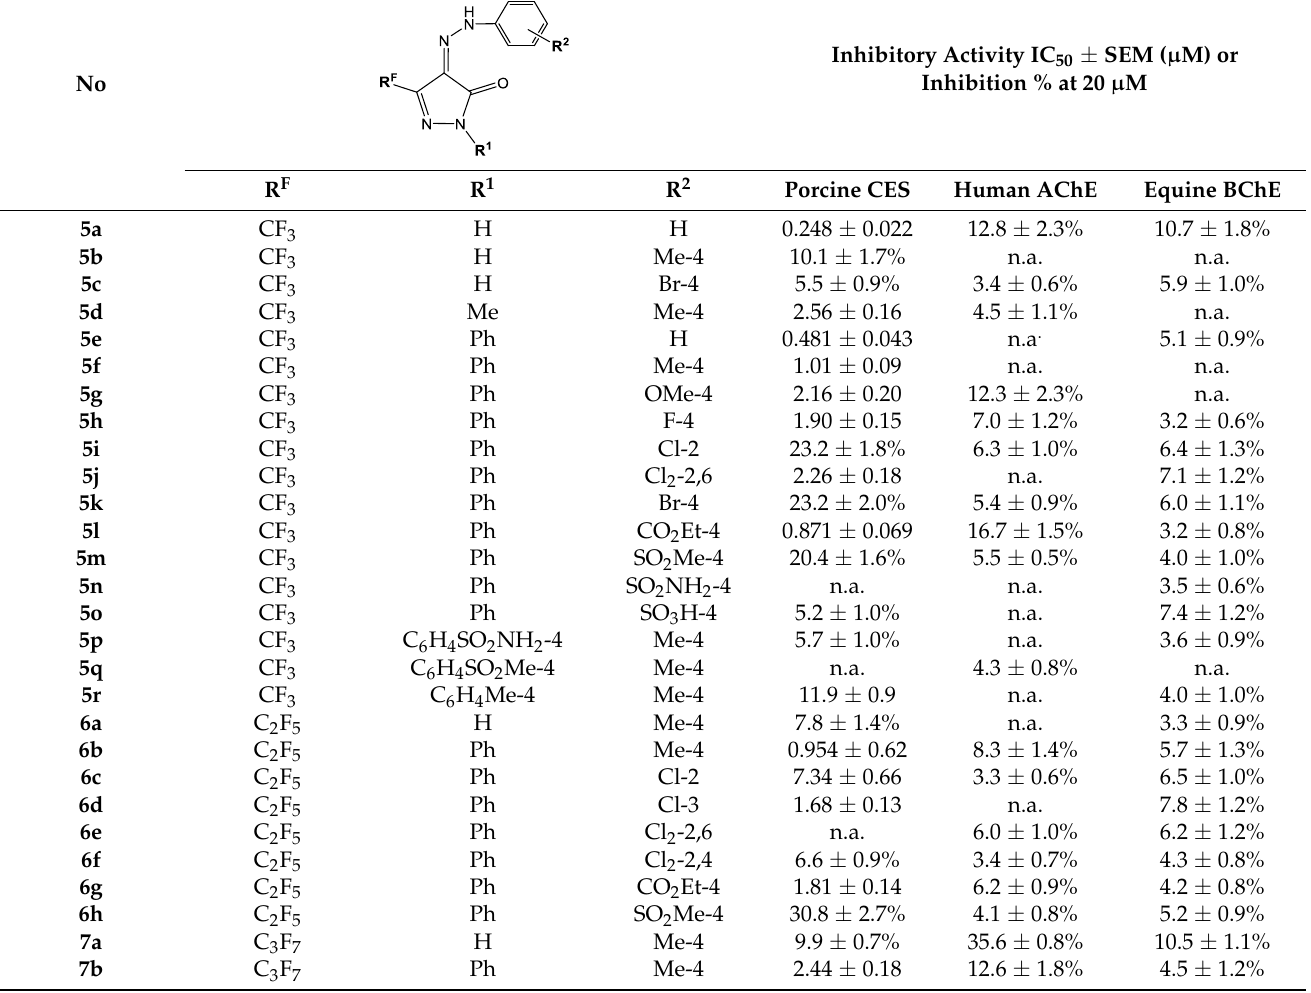
Table 3. Esterase profile of 4-AHPs 5–9 .